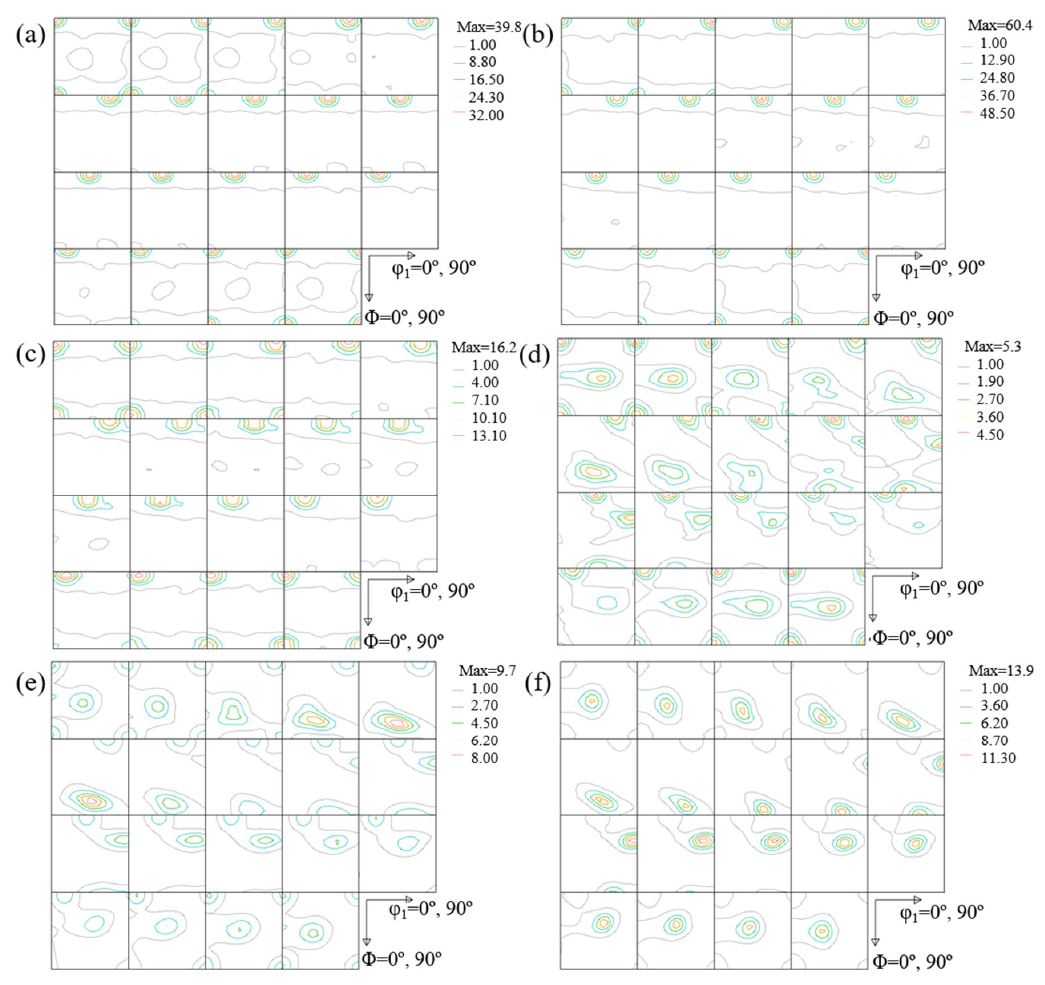
Figure 3. Three-dimensional ODF of the as-annealed and cold-rolled specimens; ( a ) as-annealed; ( b ) Δt/t 0 = 10%; ( c ) Δt/t 0 = 30%; ( d ) Δt/t 0 = 50%; ( e ) Δt/t 0 = 70%; and ( f ) Δt/t 0 = 90%.